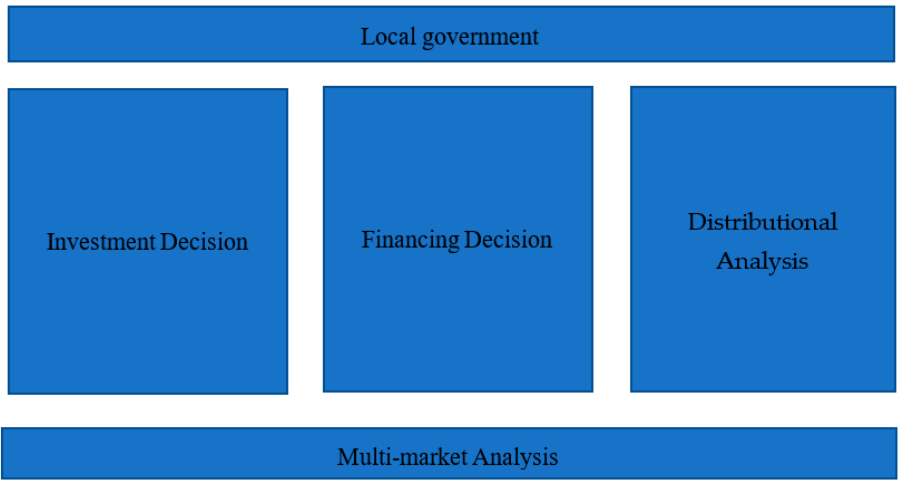
Figure 1. Cost and benefit analysis (CBA) for a municipality.